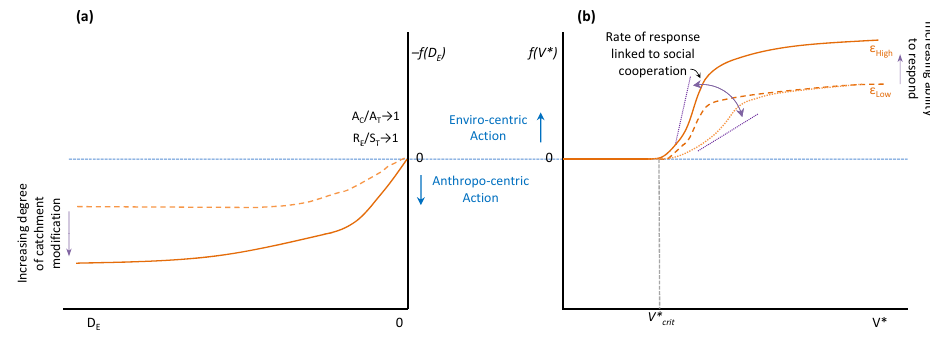
Figure 5. A hypothetical illustration of how the Behavioural Response functions vary according to: (a) the change in catchment demand for expansion, D E , and; (b) the change in collective community sensitivity, V ∗ . The functions can be customised according to factors such as community cooperation or technological capability for enacting modifications to the catchment as indicated by the different lines.